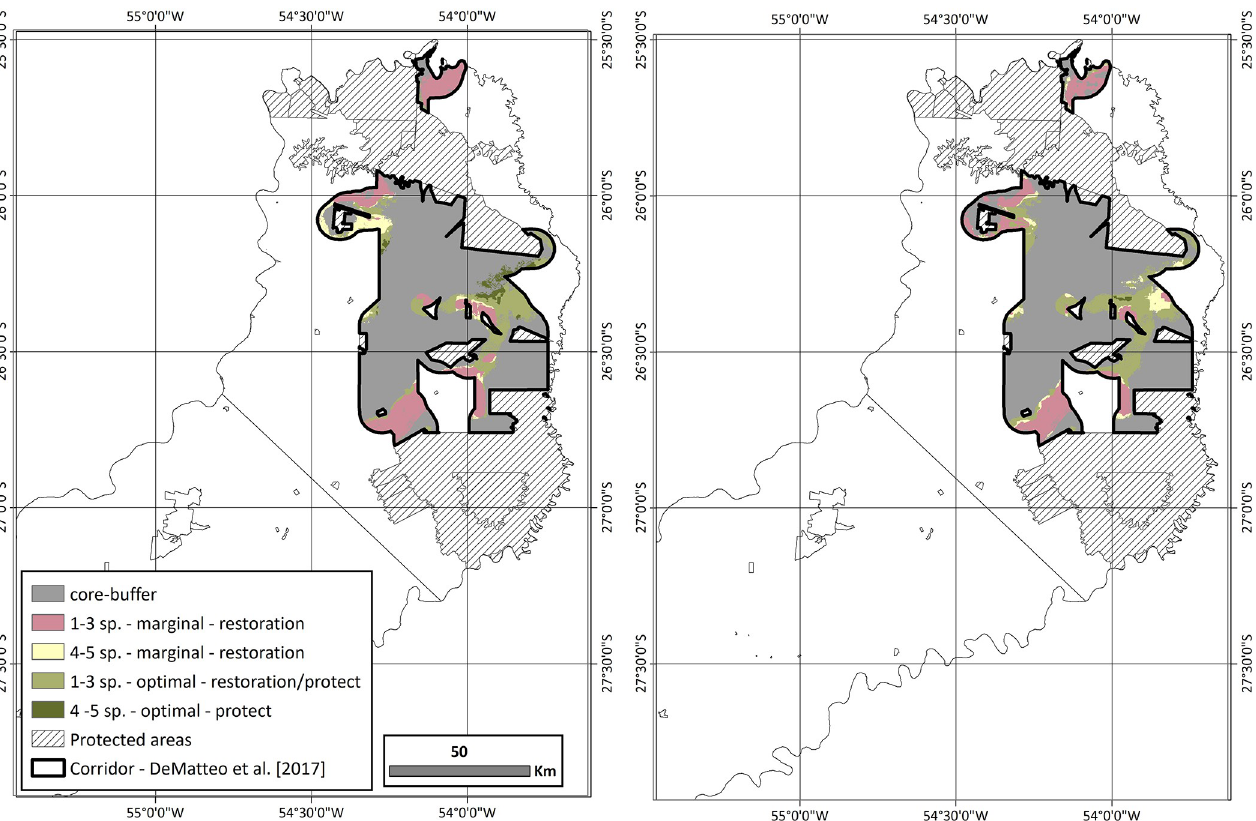
Fig 4. The potential species richness (PSR) is represented as a summary of the proportion (%) of marginal and optimal habitat defined as suitable in the northern-central zone for Model 1 and Model 2. Presented is the overlap of the potential species richness (PSR) with defined marginal and optimal habitats for each model with the DeMatteo [1] corridor, specifically the connectors or those areas defined as having the lowest levels of PSR and habitat integrity. Areas in the connectors are defined by the type of habitat (marginal or optimal), the number of overlapping species (1–5), and whether habitat restoration and/or protection are needed. The remainder of the corridor is generalized as the core buffer, as it corresponds to the DeMatteo [1] model.